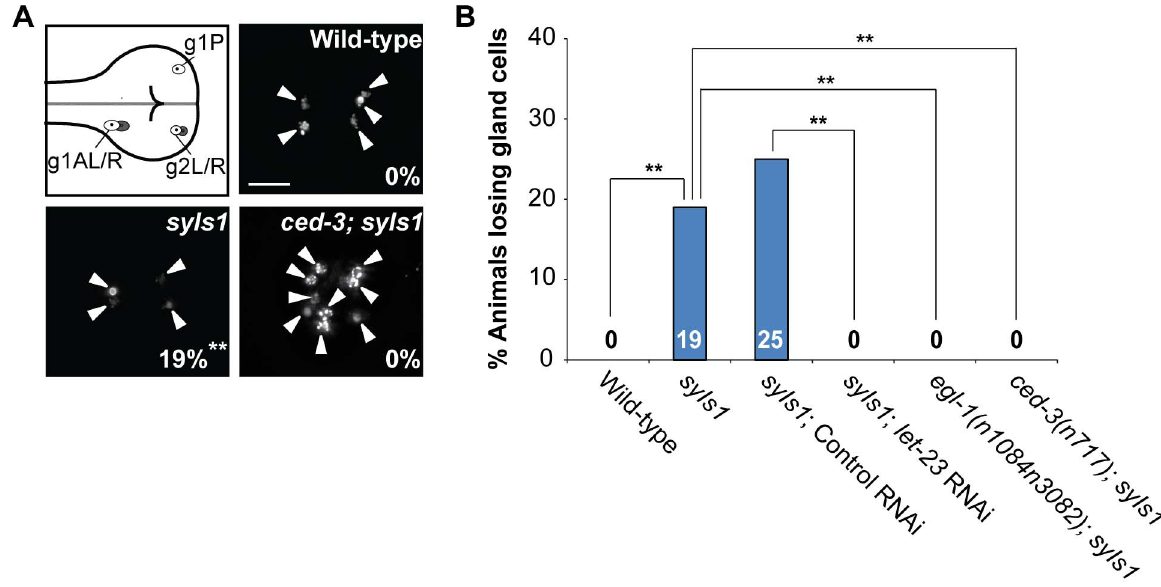
Figure 2. Overexpression of lin-3 induces ectopic gland cell death(s) through let-23 and the core PCD pathway. (A) Monomeric red fluorescent protein (mRFP) images of the wild-type, syIs1 , and ced-3(n717); syIs1 worms expressing P B0280.7 ::4Xnls::mrfp are shown. The arrowheads indicate cells expressing mRFP. The percentage of animals losing gland cell(s) is shown in the bottom right corner. **indicates P , 0.001 when compared to wild-type (Fisher’s exact test). One hundred L4 animals were scored for each genotype. The image stacks were merged by maximum intensity projection using Image J. Scale bar: 10 m m. (B) The percentage of worms losing gland cell(s) of the indicated genotypes was shown. **indicates P , 0.001 (Fisher’s exact test). More than forty worms were scored for each